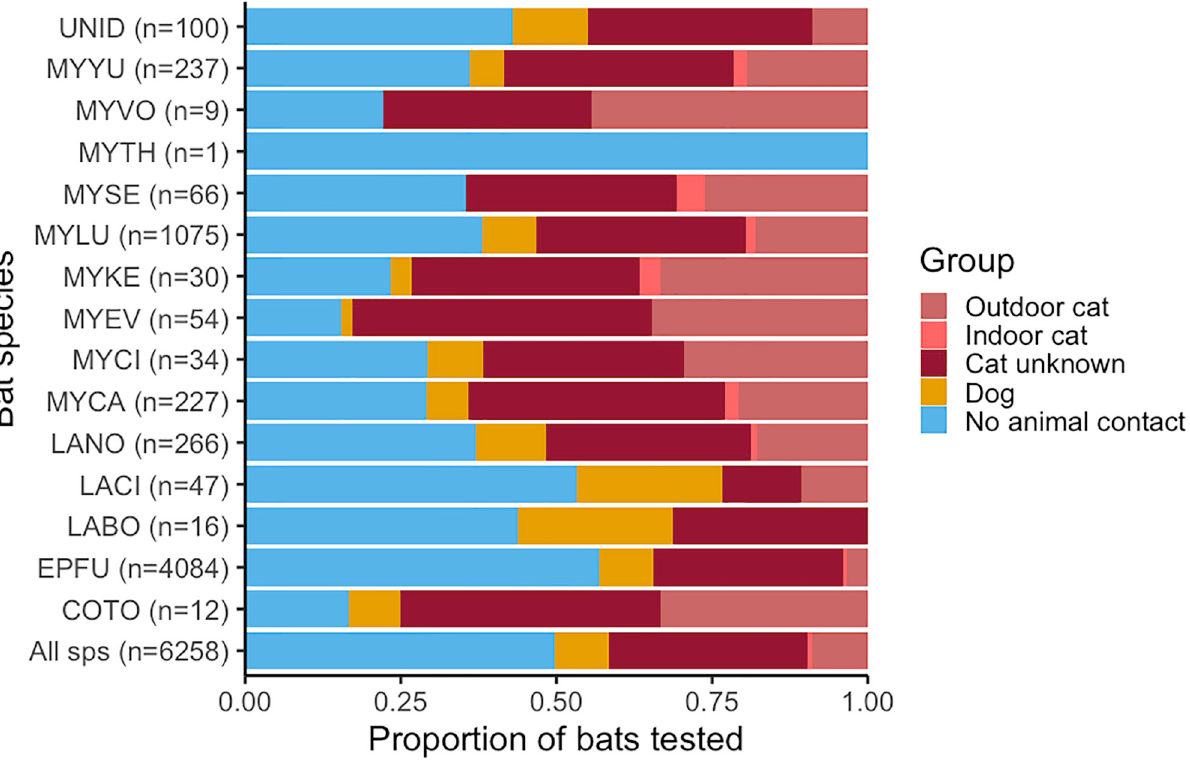
Fig 2. Proportion of bat submissions across all provinces from 2014–2020 that were associated with outdoor cats, indoor cats, cats of unspecified lifestyle, dogs and no domestic animal. Bat species codes are provided in the text.